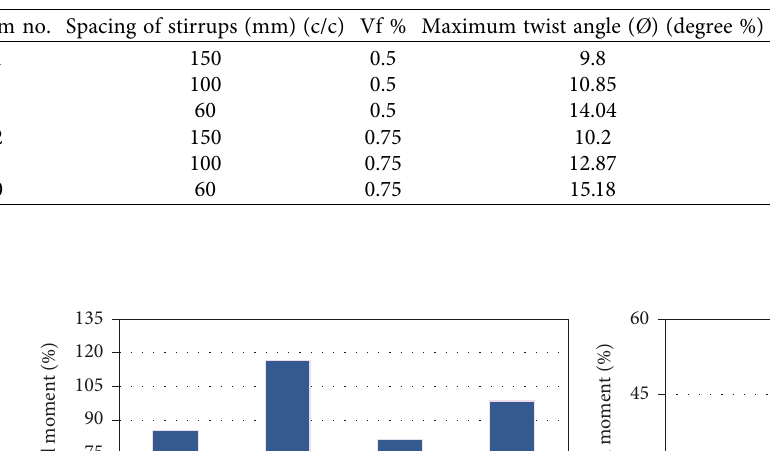
Table 8: Effect of stirrups spacing on the twist angle.